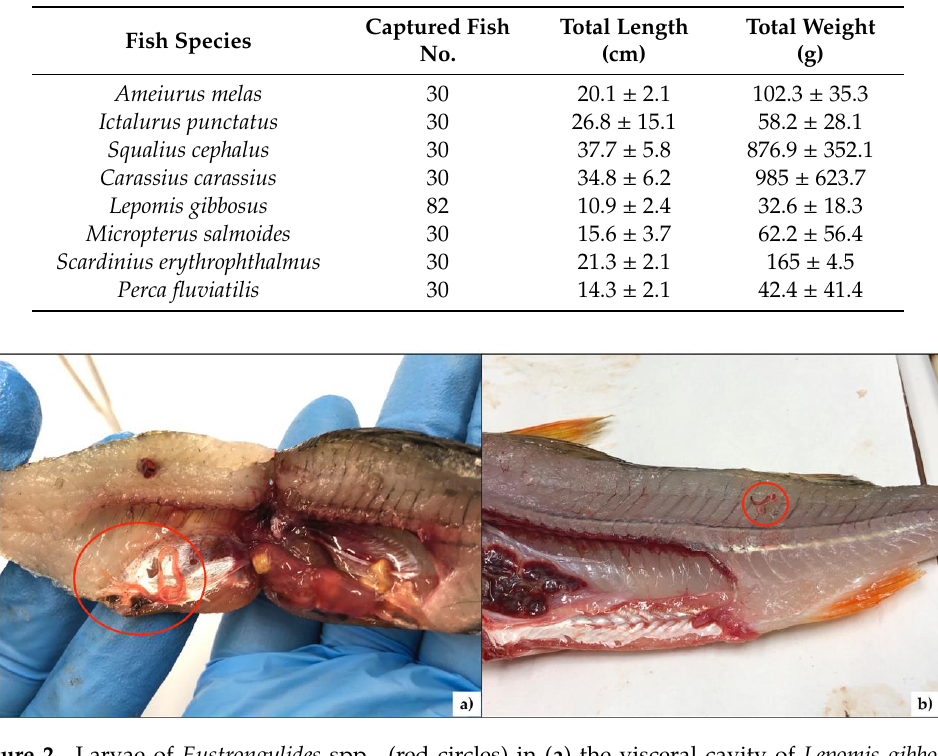
Table 1. Total length (cm) and total weight (g) of fish (N) from Lake San Michele. Plus-minus values are the mean ± standard deviation (SD).